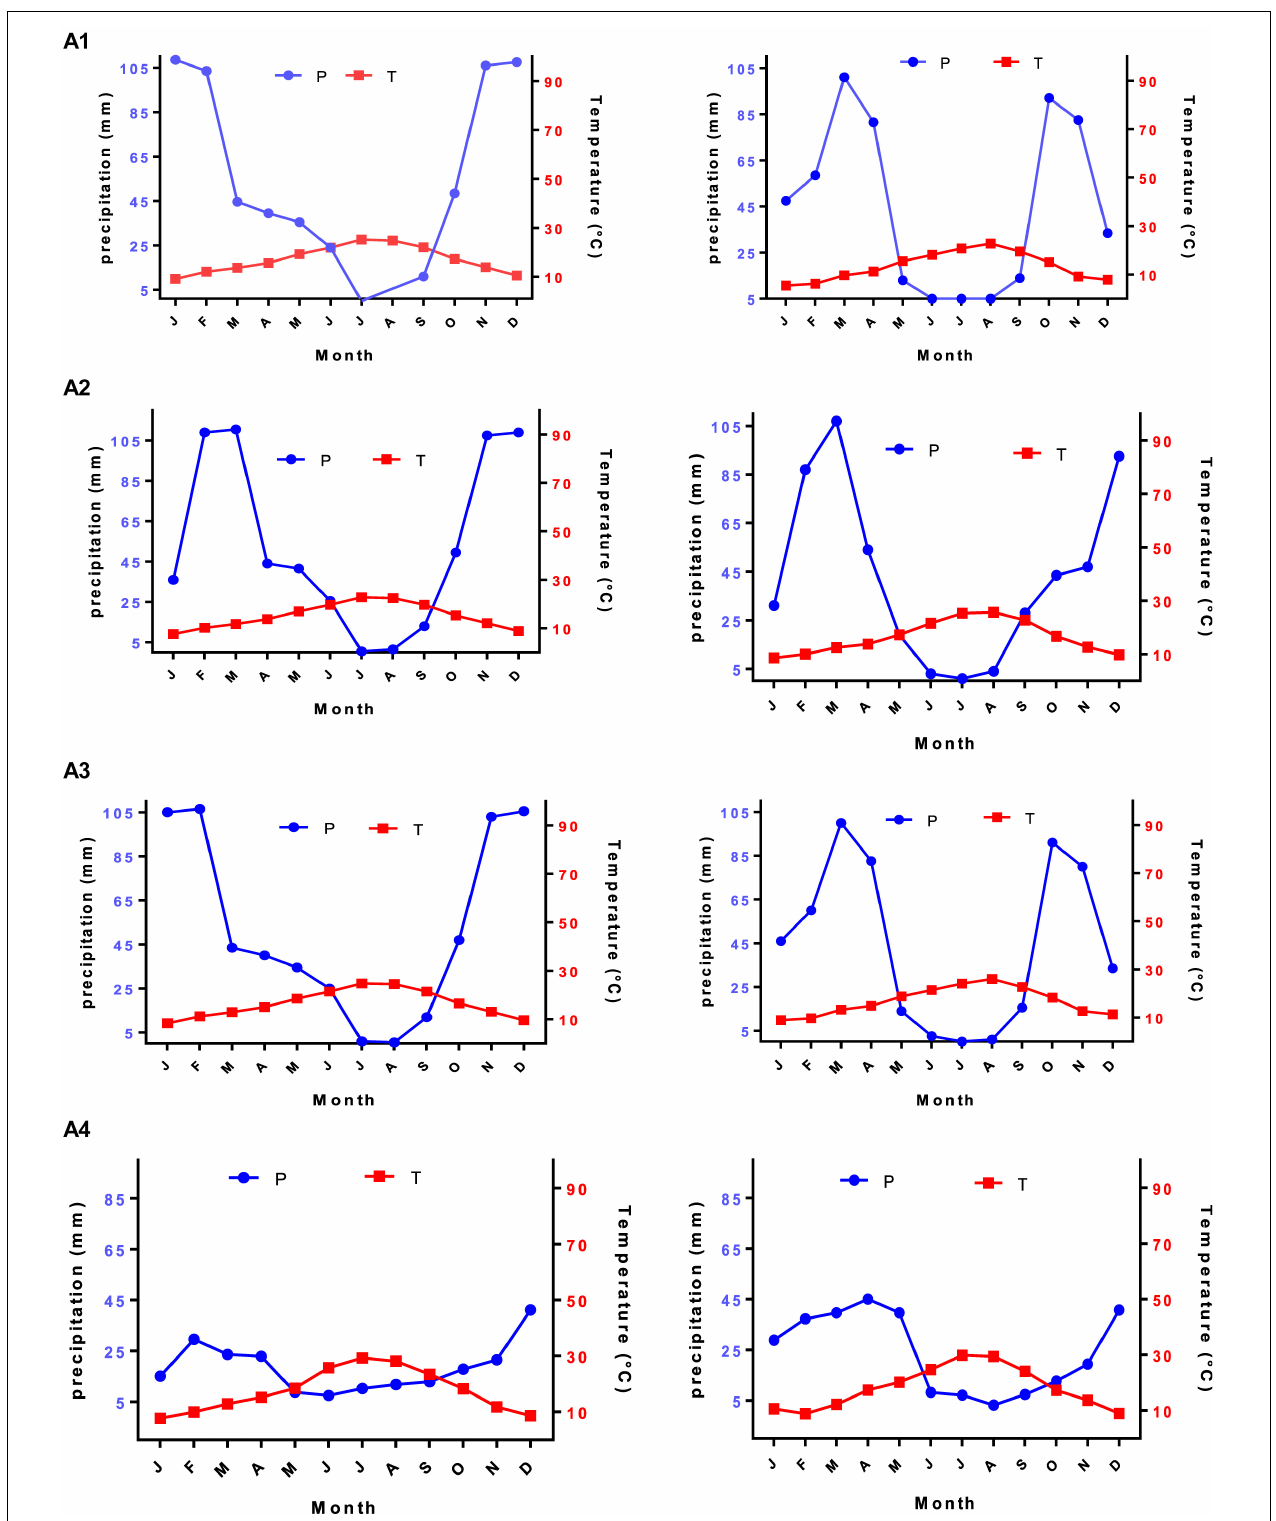
FIGURE 3 | Ombrothermal diagram of studied stations for the new (2010–2019) and old (1960–1970) periods.